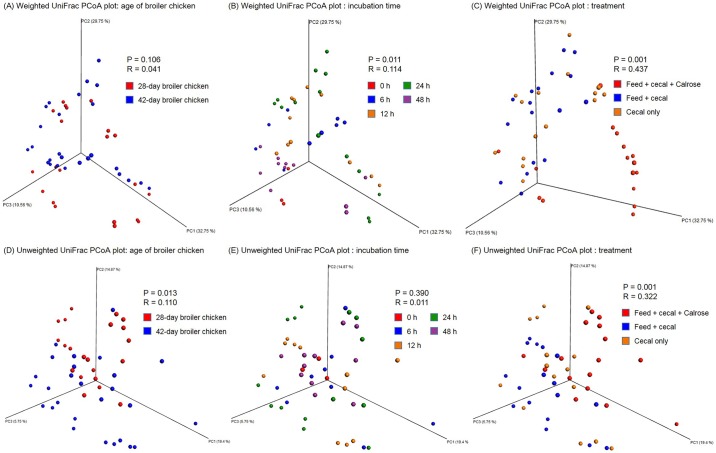
Beta diversity analysis among groups.(A-C) Weighted and (D-F) unweighted UniFrac PCoA plots of individual sample in each group.